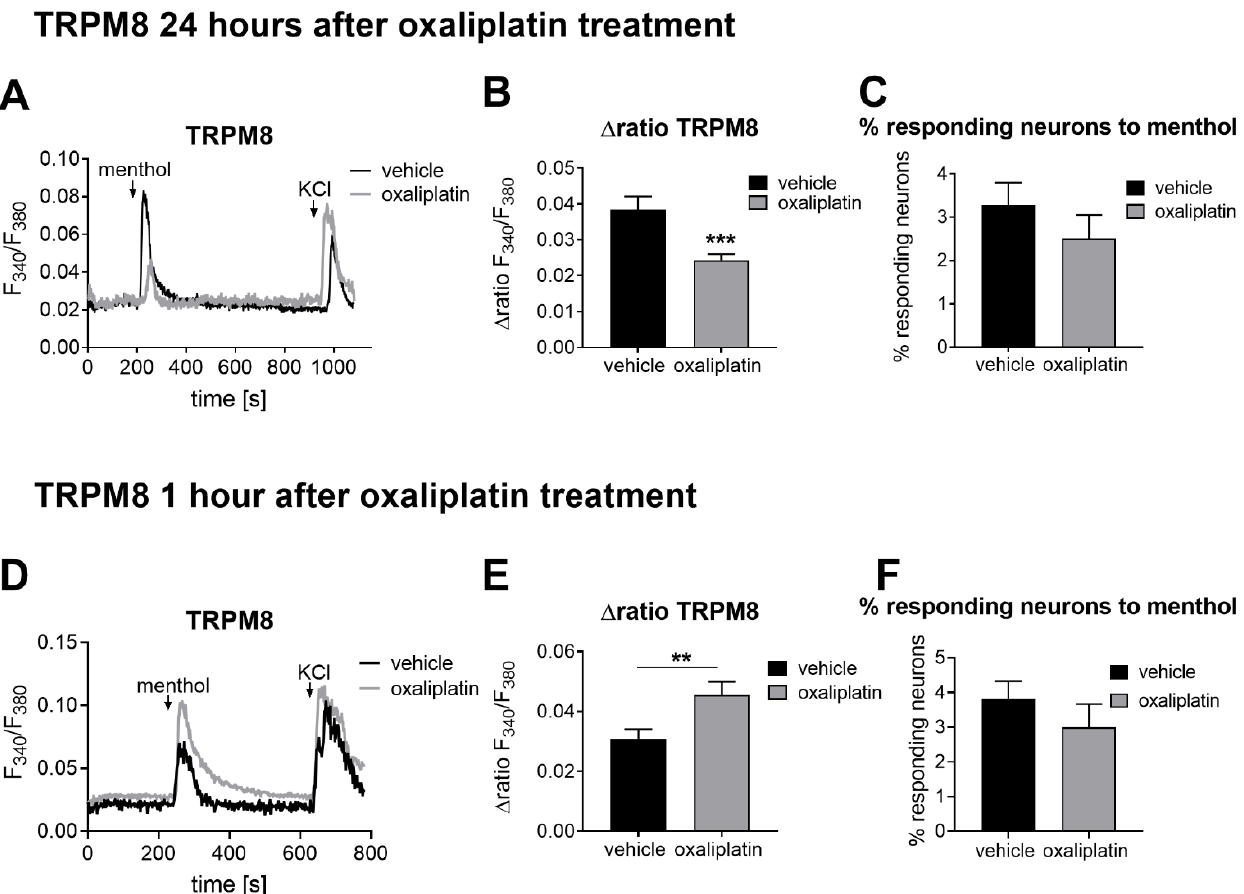
Figure 1. TRPM8 channel activity and number of neurons responding to TRPM8 channel specific agonists 24 h and 1 h after oxaliplatin (3 mg/kg) or vehicle treatment. ( A , D ) Representative Ca 2+ responses after TRPM8 channel stimulation with menthol after ( A ) 24 h (menthol 100 µ M, 30 s) or ( D ) 1 h (menthol 300 µ M, 45 s) after oxaliplatin treatment. ( B , E ) ∆ ratio F 340 /F 380 of the amplitude after a transient Ca 2+ influx after TRPM8 channel stimulation ( B ) 24 h or ( E ) 1 h after oxaliplatin treatment. Data represent the means ± SEM from n = 24–64 primary sensory neurons per condition from n = 2–5 mice; ** p < 0.01; *** p < 0.001; unpaired two-tailed t -test with Welch’s correction. ( C , F ) Percentage of neurons responding to TRPM8 ( C ) 24 h or ( F ) 1 h after oxaliplatin treatment. Data represent the means ± SEM from n = 20–42 independent measurements per condition; unpaired two-tailed t -test with Welch’s correction. Primary sensory neurons were identified by stimulating the DRG cultures with 50 mM KCl for 60 s.